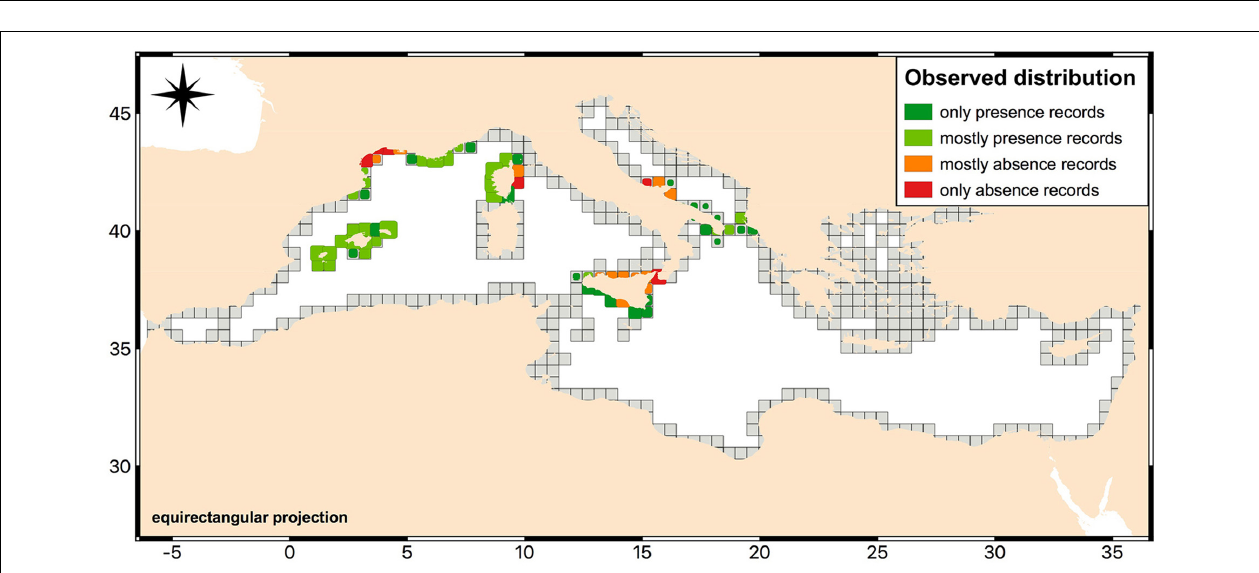
FIGURE 1 | Distribution of Cystoseira canopies across the Mediterranean Sea. Map created with QGIS software (QGIS Development Team, 2018. QGIS Geographic Information System. O3.Open Source Geospatial Foundation: https://www.qgis.org/it/site/).